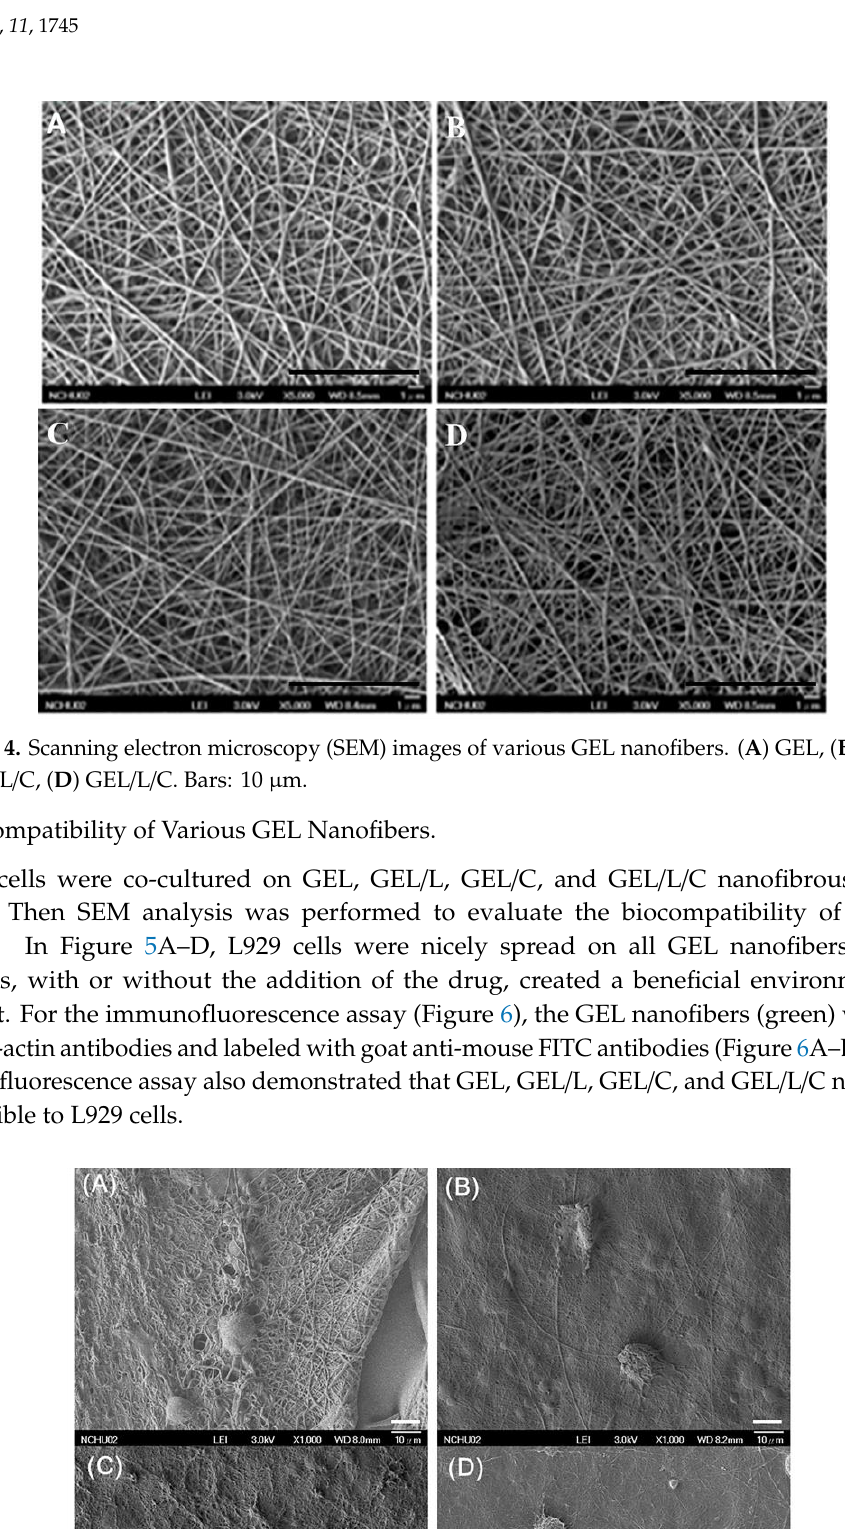
Figure 6. Immunofluorescence staining of L929 cells seeded and grown on different GEL membranes 24 hr. (A)GEL (B) GEL/L (C) GEL/C (D) GEL/L/C. 3.4. Wound Healing Effect of Bilayer Nanofibrous Scaffolds in STZ Diabetic Rats 3.4.1. GC/L/C Bilayer Nanofibrous Scaffolds Accelerated Wound Recovery Rate